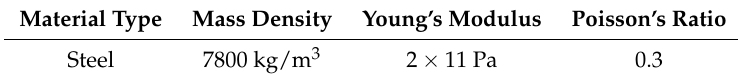
Table 2. Material properties in simulations.